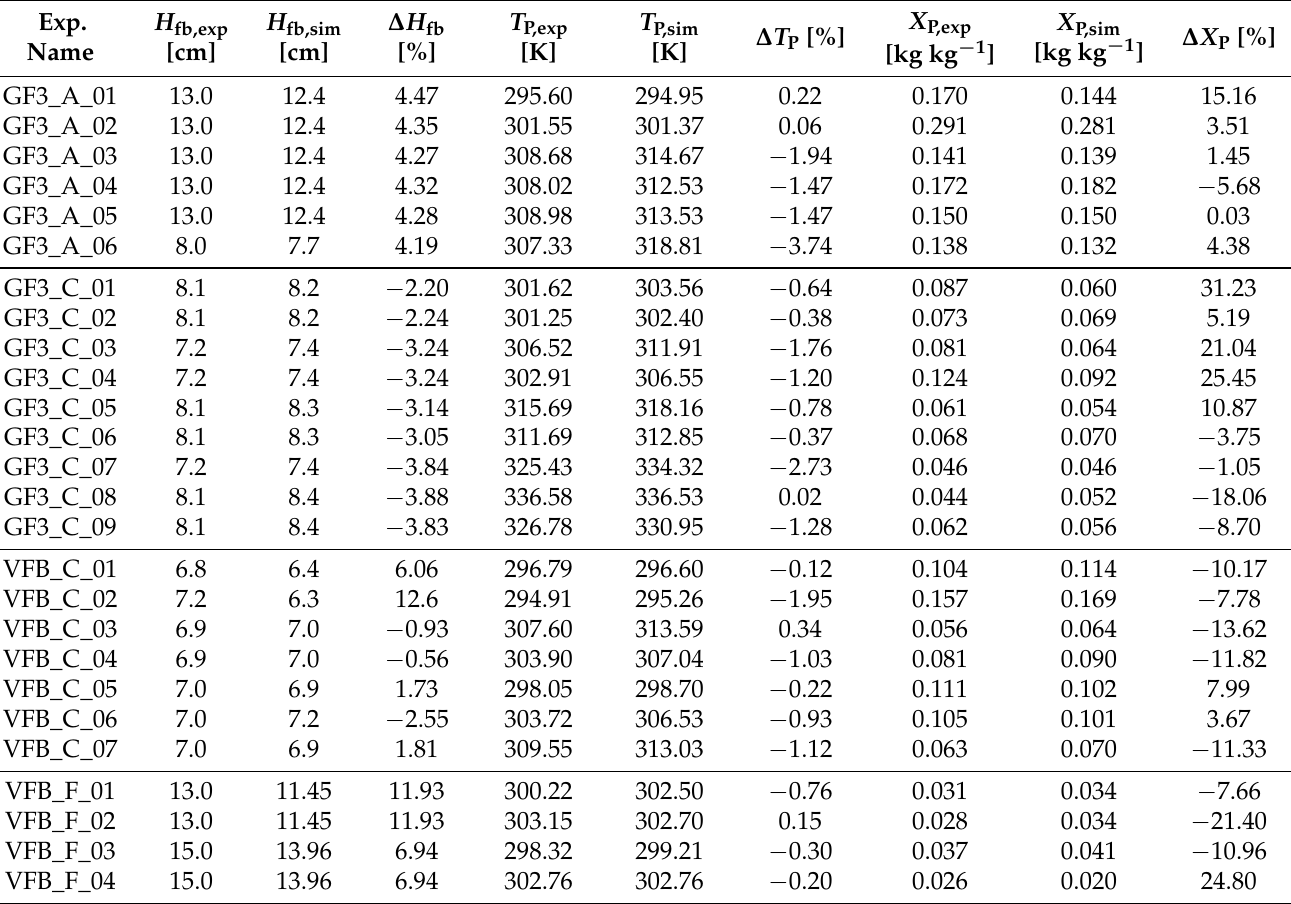
Table A2. Overview of experimental and simulation results including relative deviations; negative relative deviations indicate over predictions of the model, positive relative deviations indicate model under predictions.